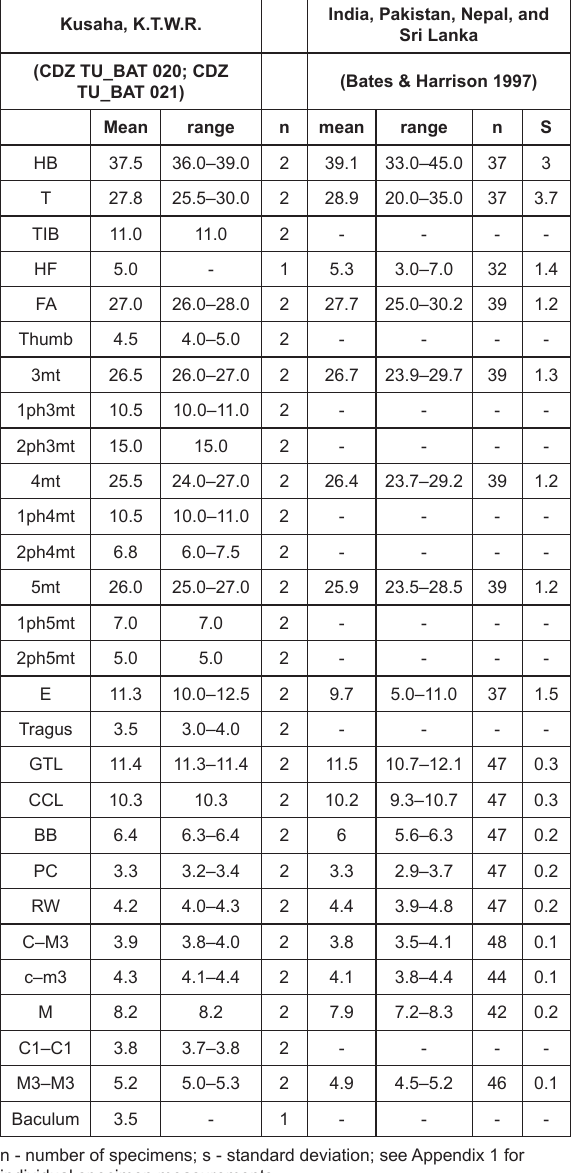
Table 3. Selected external, cranial, and dental measurements (in mm.) of Pipistrellus tenuis (CDZ